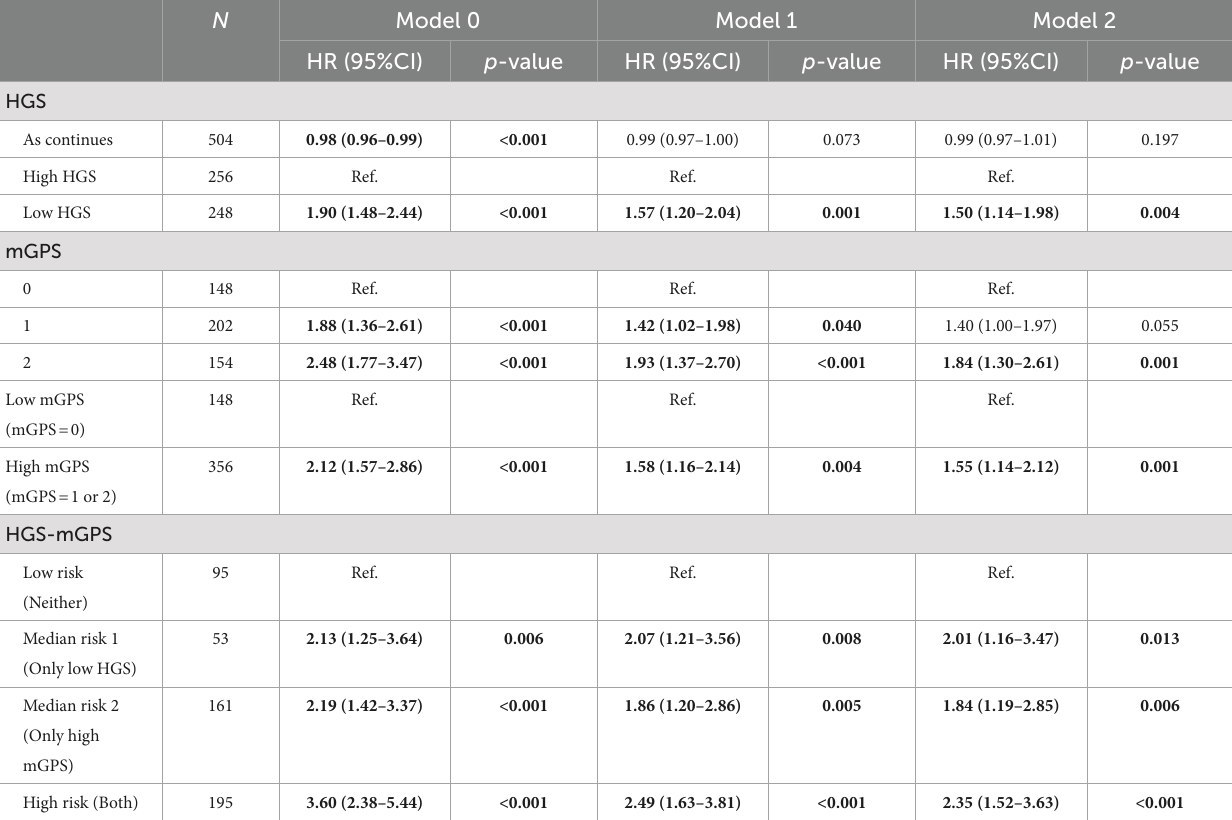
TABLE 2 Association of each indicator and overall survival in patients with liver cancer according to cox regression models adjusted for potential